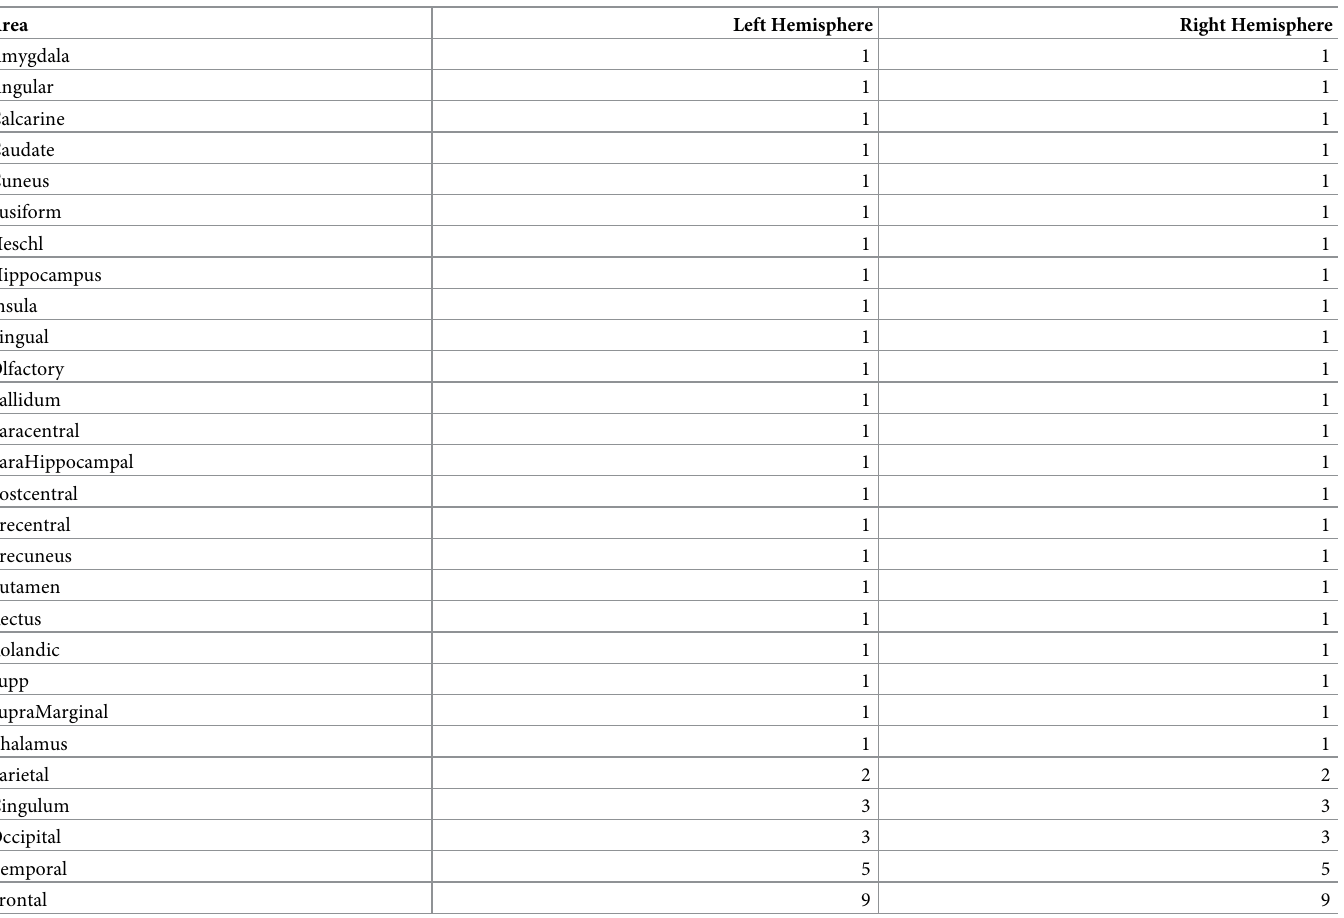
Table 4. Number of ROIs in each area of the brain; names follow Simpson et al.